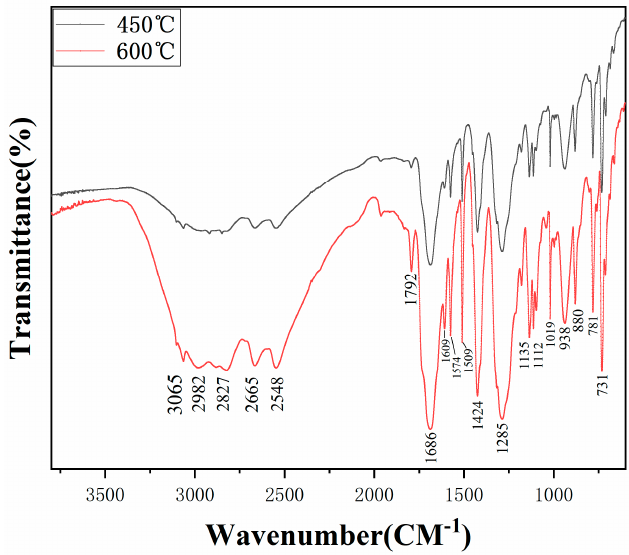
Figure 5. Fourier transform infrared spectroscopy (FT-IR) spectrums of the waxy products obtained at 450 °C and 600 °C without catalyst .